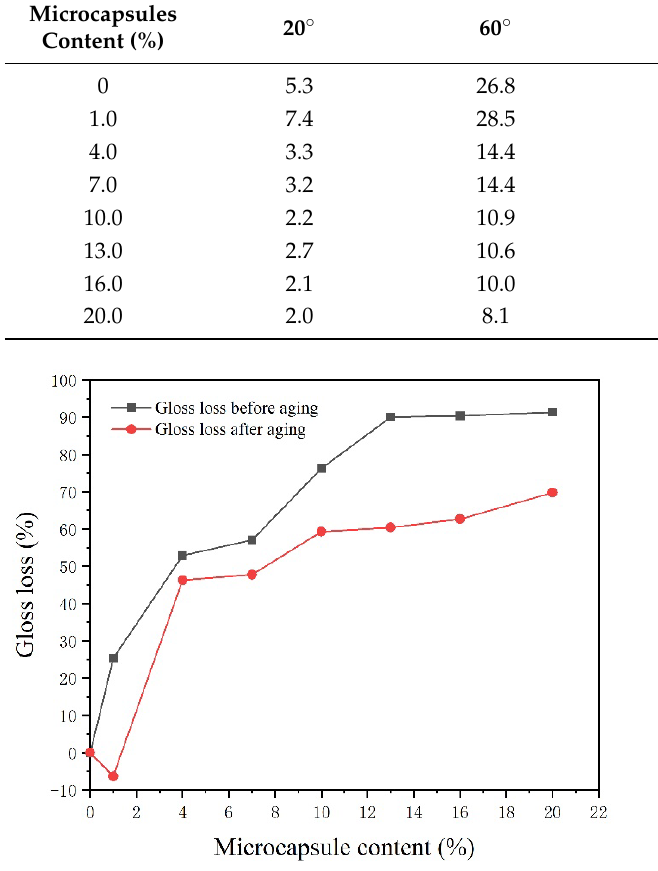
Figure 12. Effect of the microcapsule content on gloss loss of the coatings before and after aging.